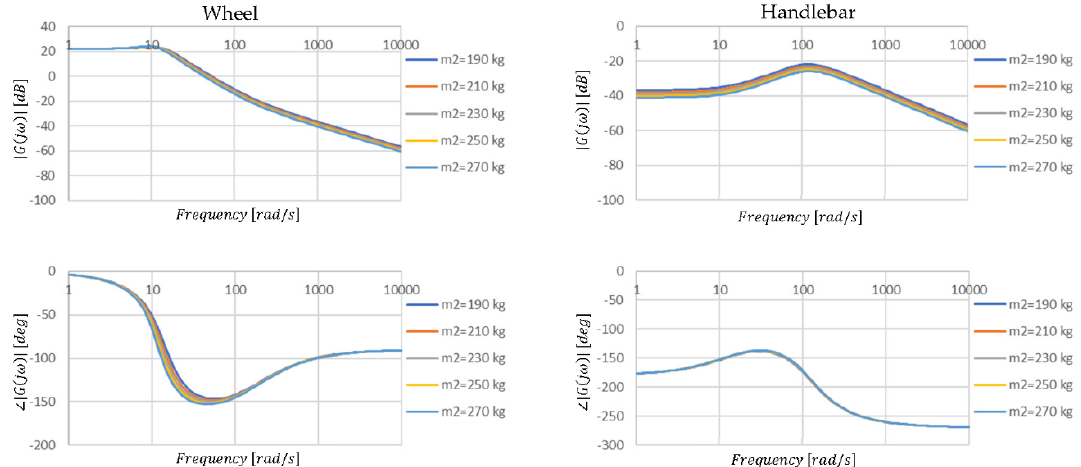
Figure 12. Amplitude and phase characteristics of the transmittance of the vertical position of the steering wheel with a change in the value of the parameter m 2 Table 7. The values of the parameters read from the graphs shown in Figure 13.